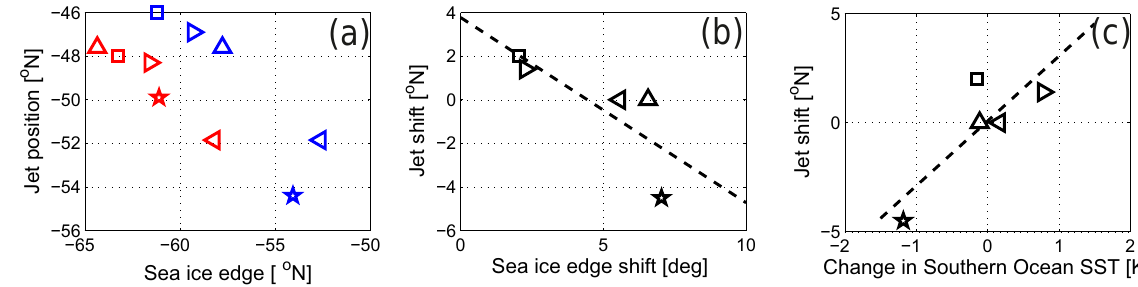
Figure 7. The relationship between sea ice, SST, and the position of the 850hPa jet. Symbols represent individual models as shown in Fig. 2. All values are calculated using annual means. Red indicates the PI; blue indicates the LGM; and black indicates changes between the PI and the LGM (LGM − PI). (a) The jet position against sea ice extent (15%), (b) jet shift against sea ice extent change, and (c) jet shift against Southern Ocean SST change. We use models where the PI jet position is poleward of 47 ◦ S, and results are interpolated to the position of the Gersonde et al. (2005) observations before each